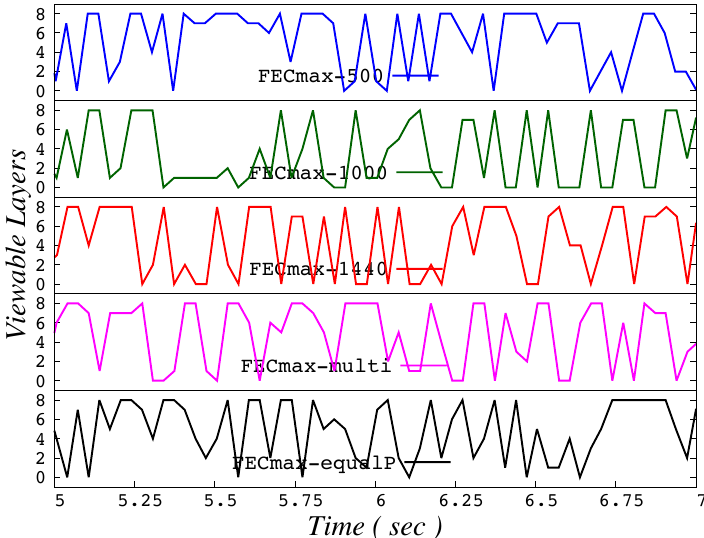
Figure A6. A two-second example of variation in viewable quality for all FEC max models, at a packet loss rate of